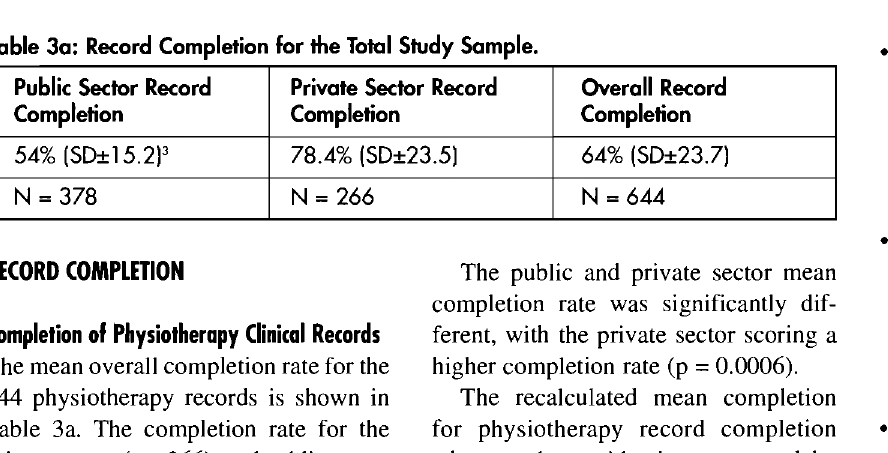
Table 3a: Record Completion for the Total Study Sample.